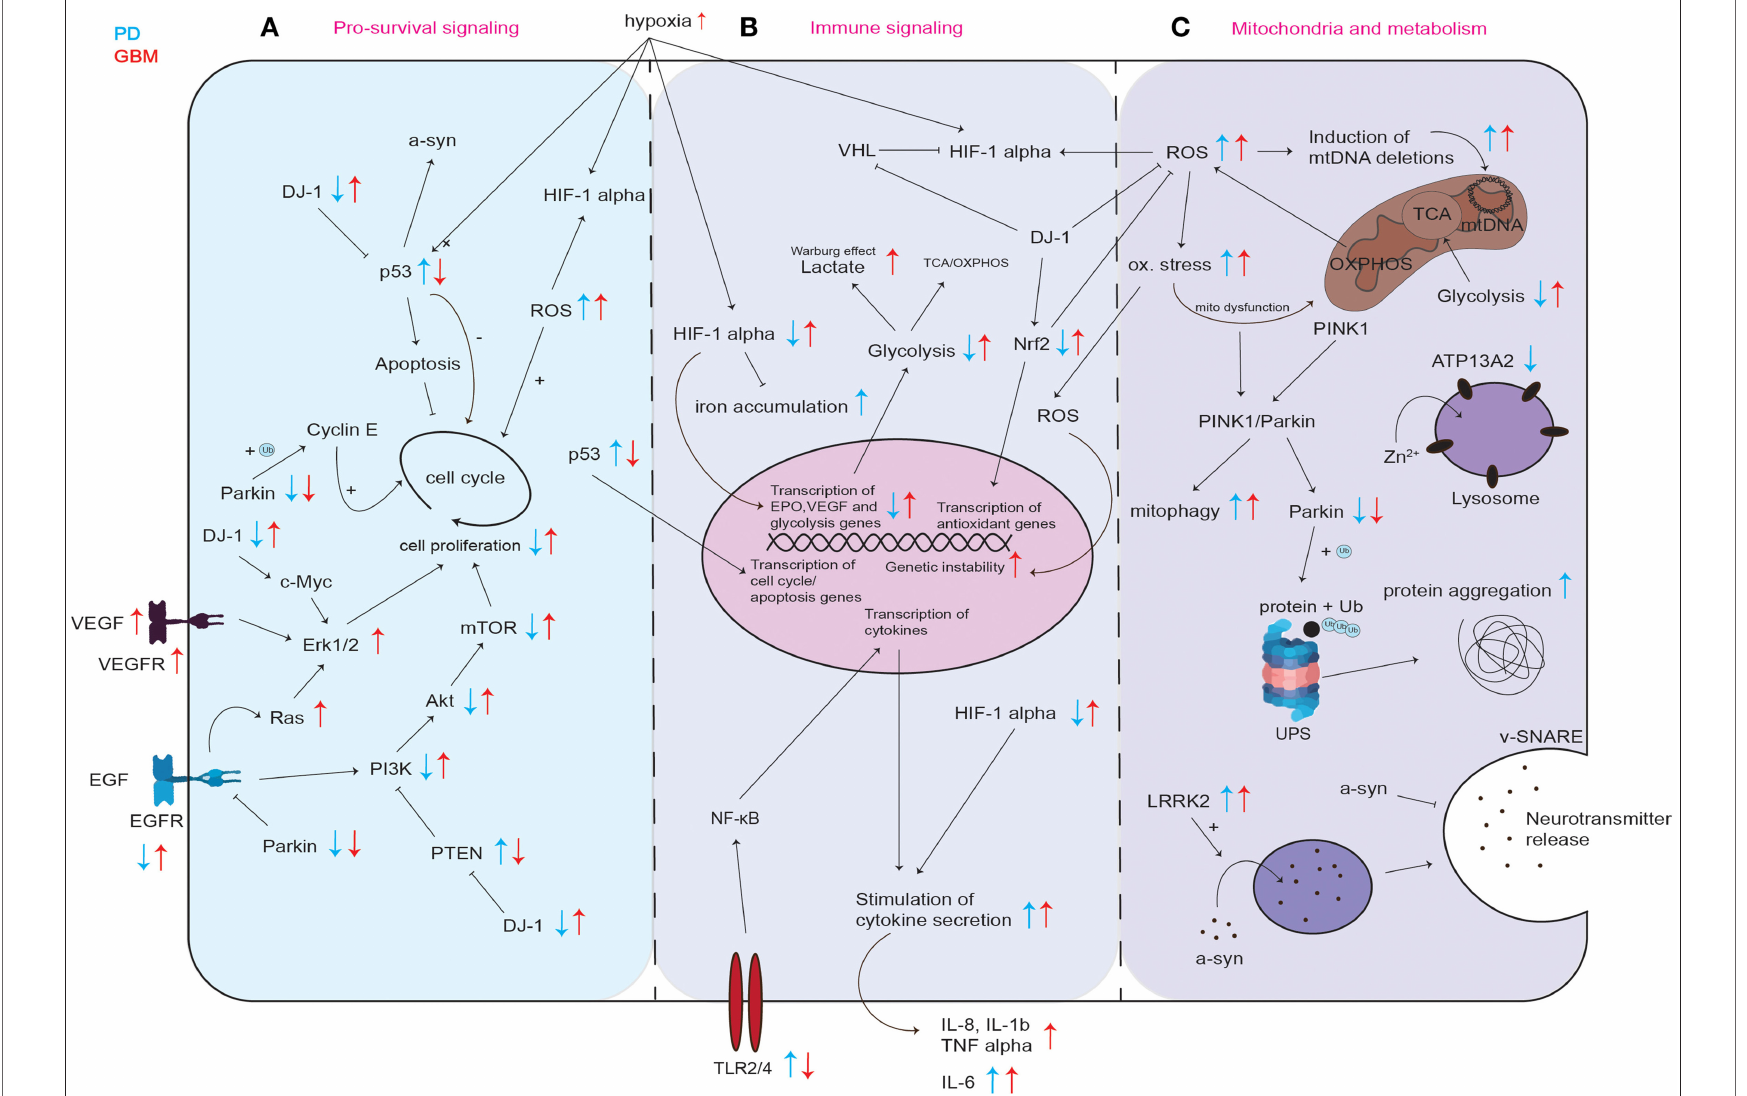
FIGURE 2 | Graphical representation of common cellular pathways described in literature to be dysregulated in PD and GBM. Dysregulation (up- or downregulation) of mediators and proteins of commonly involved mediators and proteins in PD and GBM is illustrated with blue and red arrows, while blue arrows correspond to the situation in PD, red arrows indicate the regulation in GBM. Differential regulation of discussed mediators regarding pro-survival signaling (A) immune signaling (B) and their involvement in mitochondria and metabolism (C) . UPS, ubiquitin proteasome system; ox. stress, oxidative stress; mito dysfunction, mitochondrial